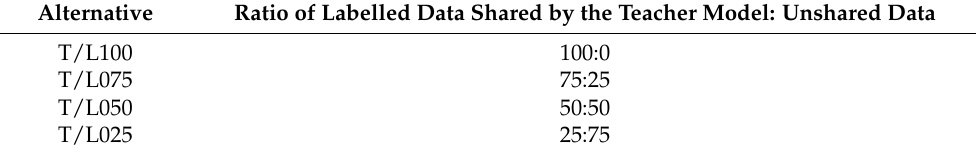
Table 1. Semi-labelled subset for validating the T/L technique, where the ratio value represents the amount of data shared by the teacher to the learner model, where the ratios of data were randomly allocated.